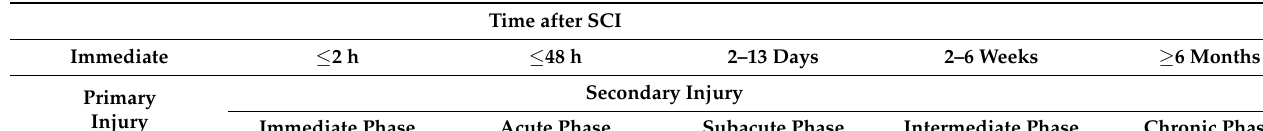
Table 1. Main pathological events in SCI by